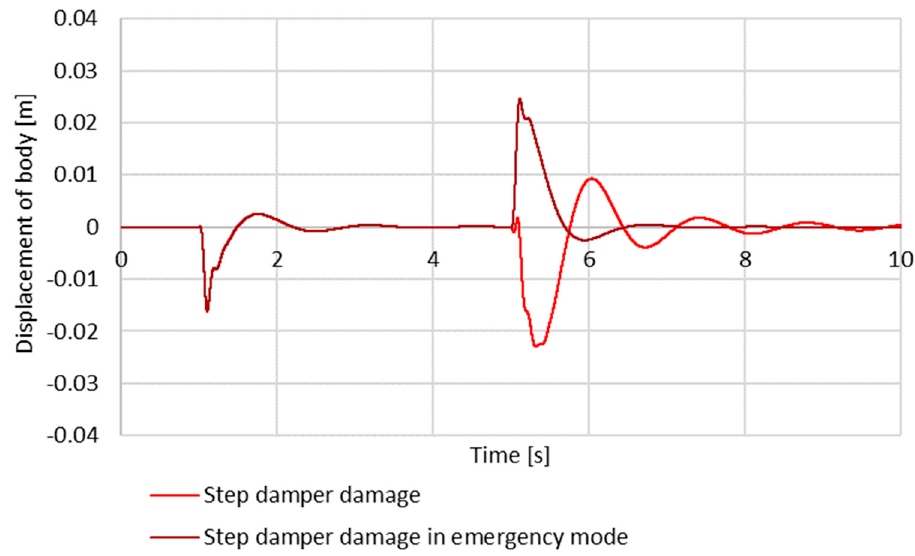
Figure 8. Body vertical displacement for a step-damaged damper with introduction of an emergency mode.